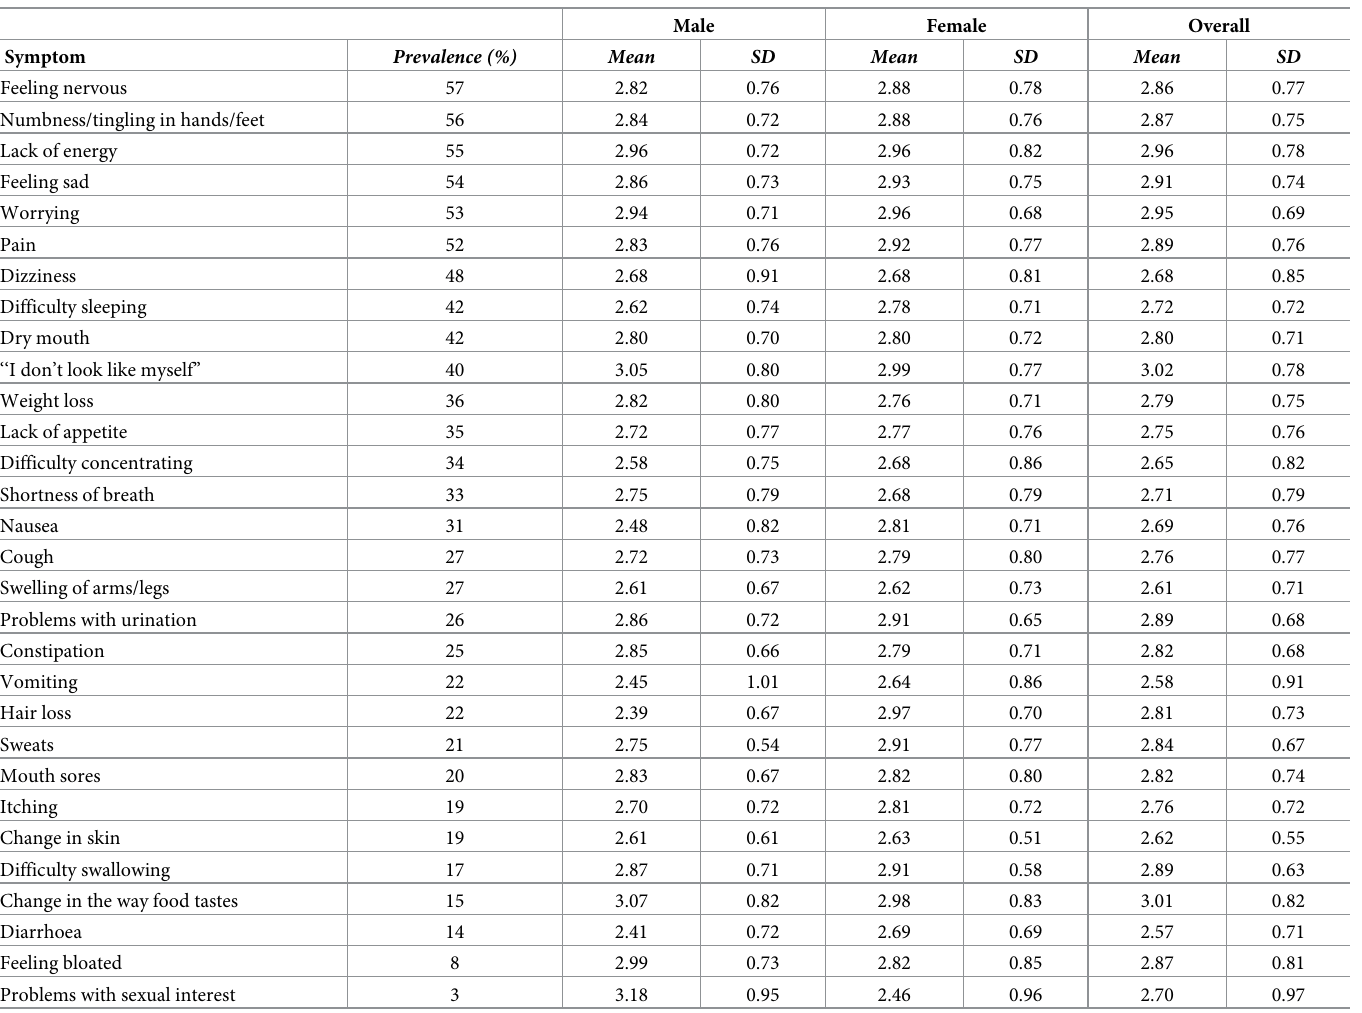
Table 2. Mean scores of the Memorial Symptom Assessment Scale (MSAS) indicating overall experience (taken from an average of frequency, severity and